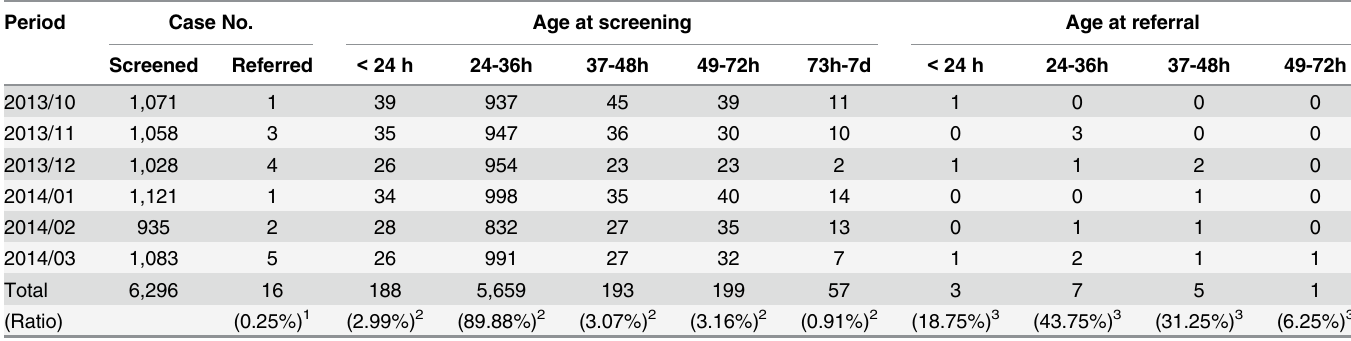
Table 2. Efficiency of CCHD screening in Taipei.